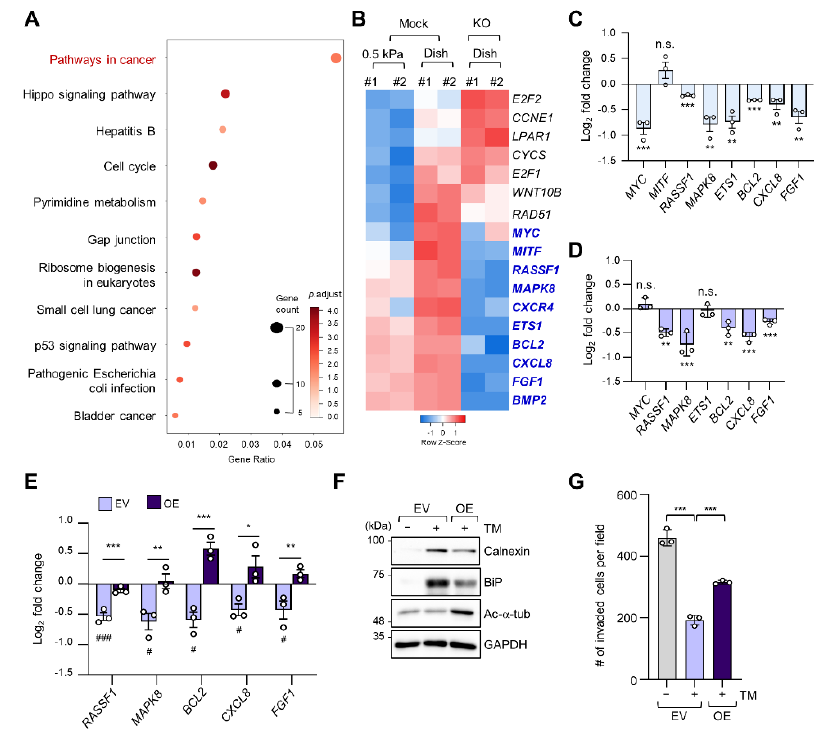
Figure 3. Microtubule acetylation induces cancer-related gene expression through the alleviation of ER stress in breast cancer cells. ( A ) Kyoto Encyclopedia of Genes and Genomes (KEGG) pathway enrichment analysis of DEGs upregulated in cells grown on a stiff matrix. The x -axis indicates the gene ratio, i.e., the ratio of DEGs in the given gene ontology (GO) term. The y -axis indicates KEGG pathways. Dot size represents the number of genes in each KEGG pathway. ( B ) Heatmap of 17 genes related to “Pathways in cancer” obtained through KEGG pathway analysis in mock and ATAT1 KO MDA-MB-231 cells. Genes with reduced expression in ATAT1 KO compared to mock-treated cells are indicated by blue letters. ( C ) mRNA levels of “Pathways in cancer” genes were decreased in ATAT1 KO MDA-MB-231 cells treated with 20 ng/mL tunicamycin for 24 h as indicated by RT-qPCR. Values represent the mean ± SD of three independent experiments. ** p < 0.01, *** p < 0.001, N.S. not significant (Student’s t -test). ( D ) mRNA levels of seven genes that were downregulated upon tunicamycin treatment shown in ( C ) in ATAT1 KD compared to shMock-treated MDA-MB-231 cells as determined by RT-qPCR. Values represent the mean ± SD of three independent